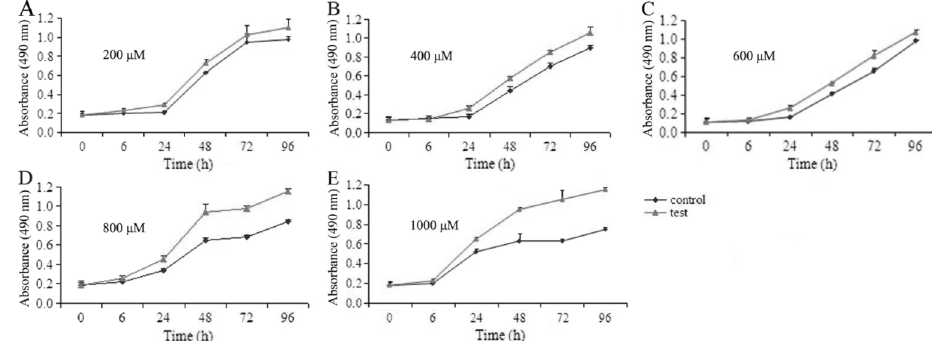
Figure 2. Cellular viability assay results of the control and test cells. The capacity for cellular viability was examined using the MTTassay and cellular viability was compared between the control and test cells (n=8). A - C , The cellular viability of the test cells was signi fi cantly greater than that of the control cells (P o 0.05) exposed to Cu-His at 200, 400, and 600 m M; D , E , the differences were signi fi cant (P o 0.01) among cells exposed to Cu-His at 800 and 1000 m M. The t -test was used for statistical